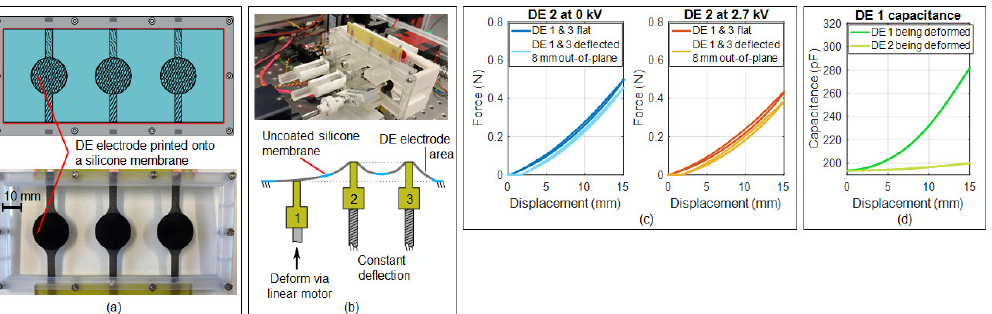
Figure 2. 3 × 1 DEA membrane w/CB/PDMS electrodes ( a ), test rig for coupling characterization ( b ), center DE actuation properties unaffected by neighbor deflection ( c ), center DE sensing properties capable of self-detection and neighbor detection ( d